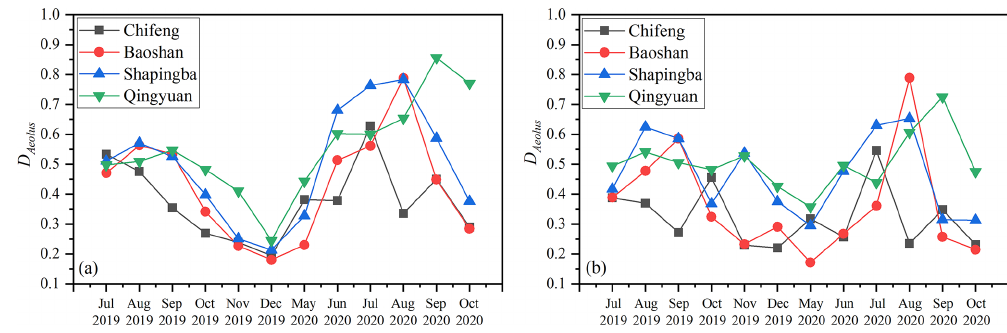
Figure 9. Changes in the monthly average of D Aeolus in different months, (a) Rayleigh-clear and (b)